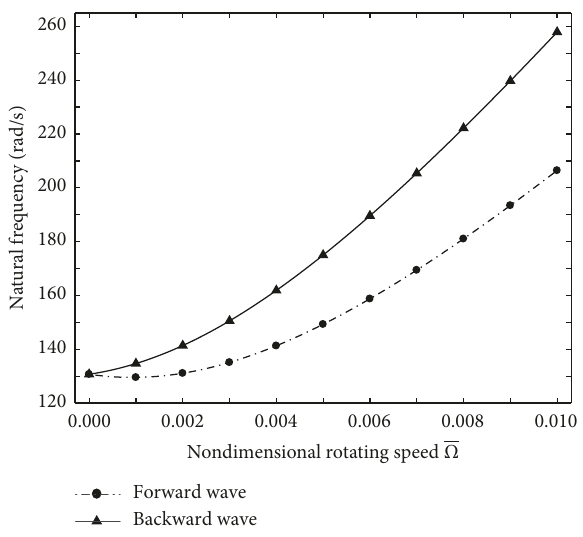
Figure 3: Natural frequencies versus rotating speed (mode: 𝑚 = 1 , 𝑛 = 4 ).